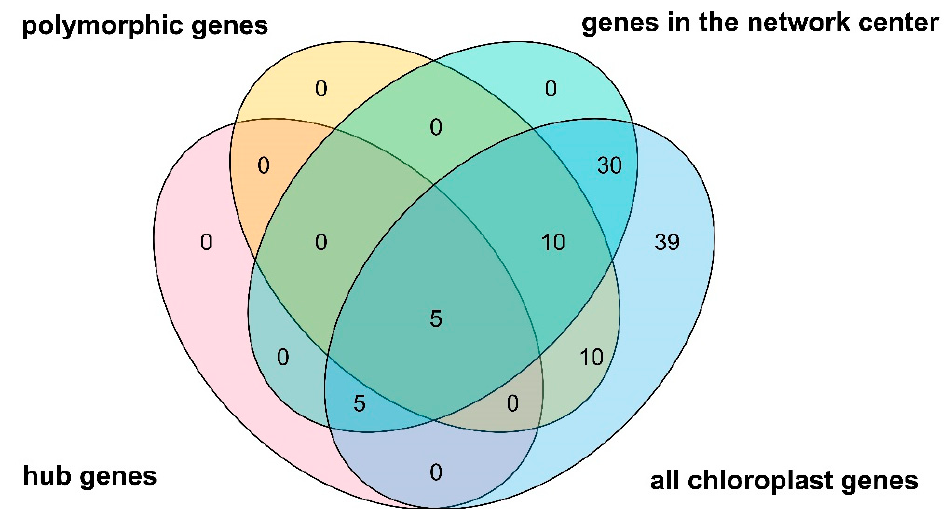
Figure 8. Venn diagram of all chloroplast genes included in the gene regulatory network for Arabidopsis thaliana chloroplast-related genes and its other genome-wide genes.